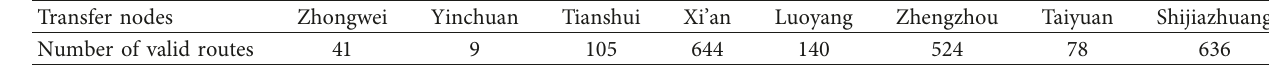
Table 6: Valid routes number for transfer nodes.